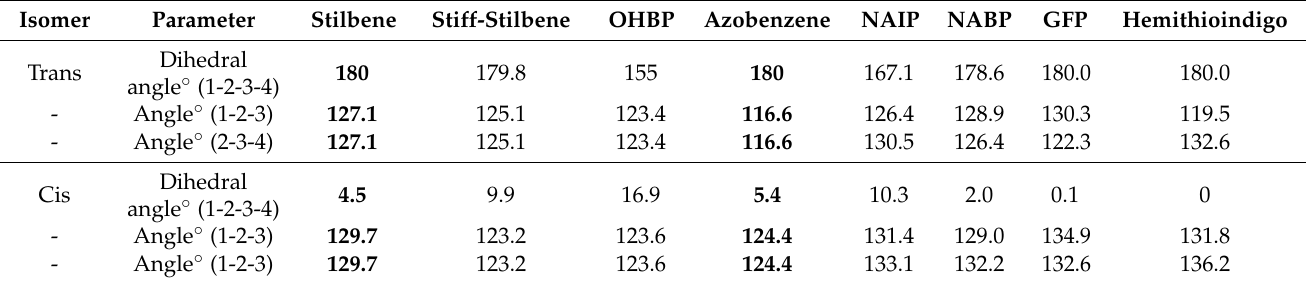
Table 5. Geometry of the isomerizable double bond in optical